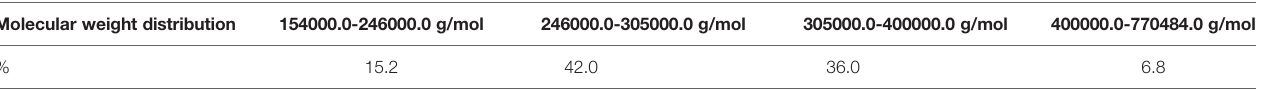
TABLE 2 | Molecular weight distribution. Molecular weight distribution